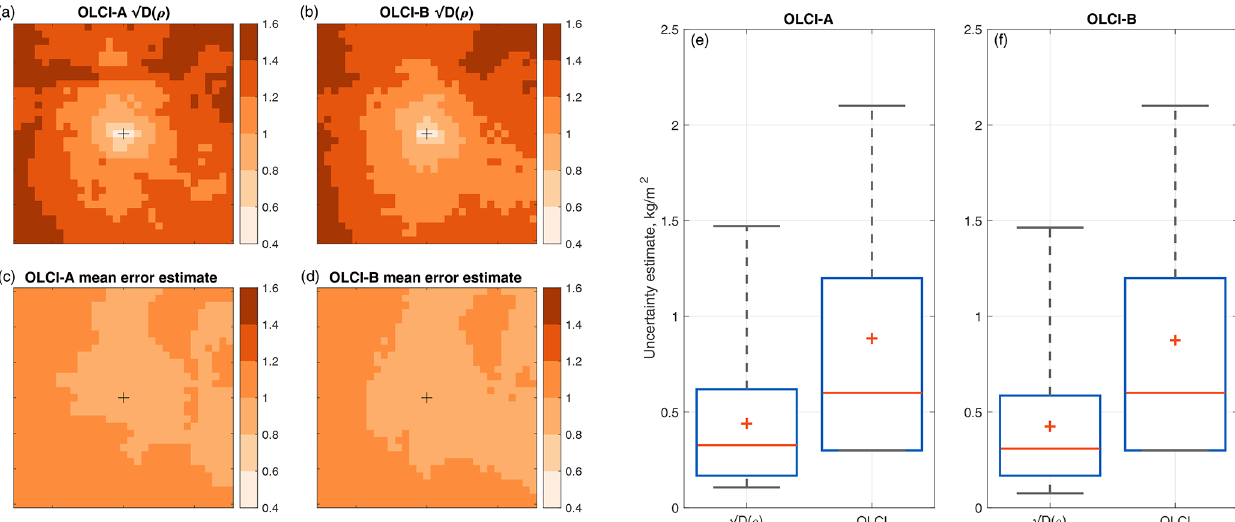
√ D(ρ) in kgm − 2 ) within macropixels, compared to the centre of the macropixel (a, b) and the square Figure 7. (a–d) Structure function ( root of mean error estimate of corresponding OLCI pixels (c, d) . (e, f) Distribution of experimental uncertainty estimates (8 pixels around √ D(ρ) and the IWV uncertainty estimates from the inversion algorithm. the centre of the macropixel) using the structure function method Red lines show the medians of the distributions and blue boxes the 16th and 84th percentiles of the distribution, with black whiskers showing the 5th and 95th percentiles. Red crosses show the means of the